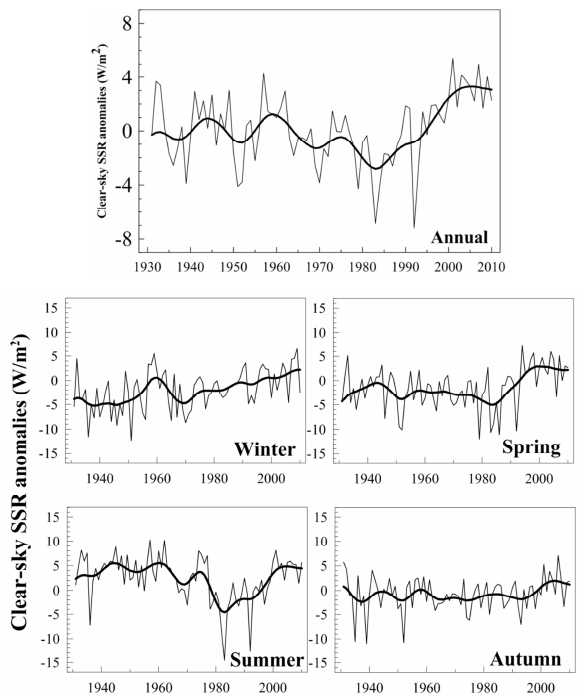
Fig. 6. Mean annual and seasonal clear-sky SSR series (thin line) in Switzerland, plotted together with the 17-yr Gaussian low-pass filter (thick line). The series are expressed as anomalies from the 1981–2010 mean. A subset of the 11 stations with more reliable SD and TCC daily is used to produce the mean time series, which only is plotted for the 1931–2010 period due to the low number of stations with records before the